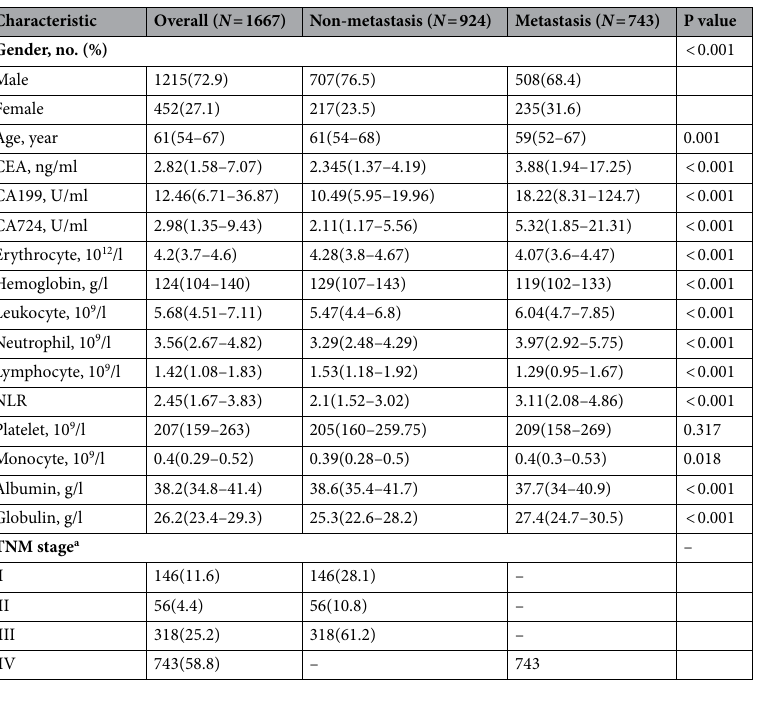
Table 1. Demographic and baseline characteristics of patients. Data are shown as number of cases and percentage or median and interquartile range. TNM tumor-node-metastasis, NLR neutrophil-to-lymphocyte ratio, CEA carcinoembryonic antigen, CA19-9 carbohydrate antigen 19-9, CA72-4 carbohydrate antigen 72-4. a 404 data missing because some patients were not treated surgically or were treated only with palliative care, resulting in unable to accurately assess the pathological